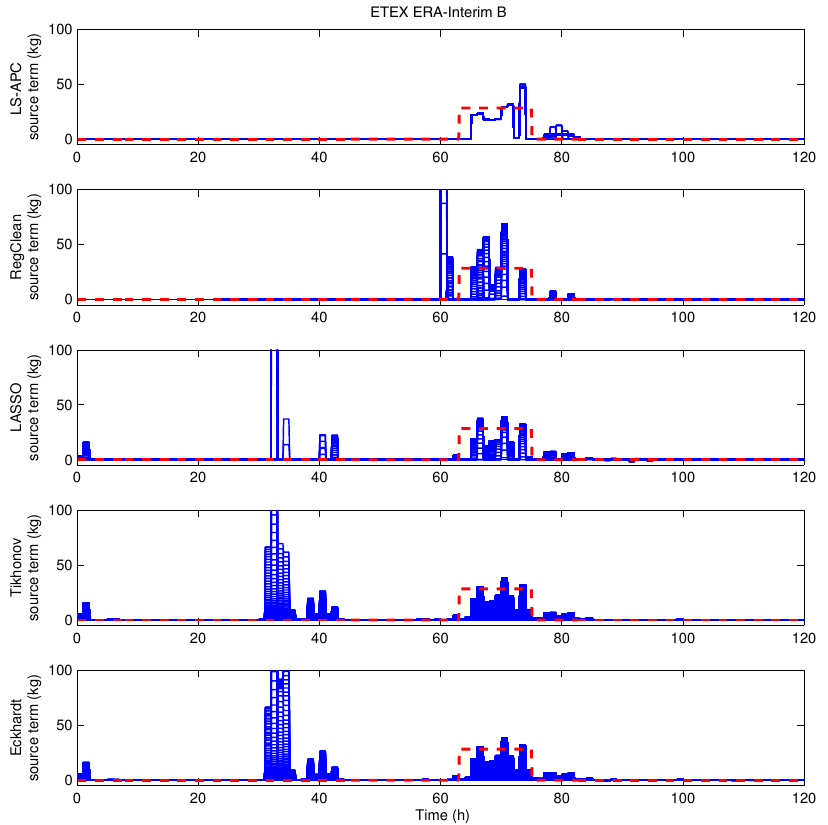
Figure 7. Comparison of the estimated source term for data ETEX ERA-Interim B for all settings (221 values) of the tuning parameter α using all algorithms. For LS-APC, all estimates are overlapping; for algorithms sensitive to this choice, lines for different values of the tuning parameter are plotted next to each other forming an area. The true source term is denoted by the dashed red